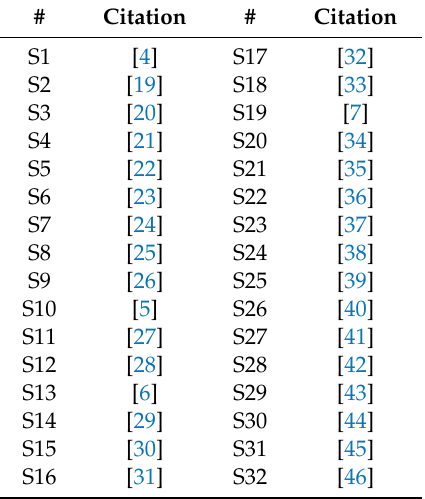
Table A1. Reviewed papers and